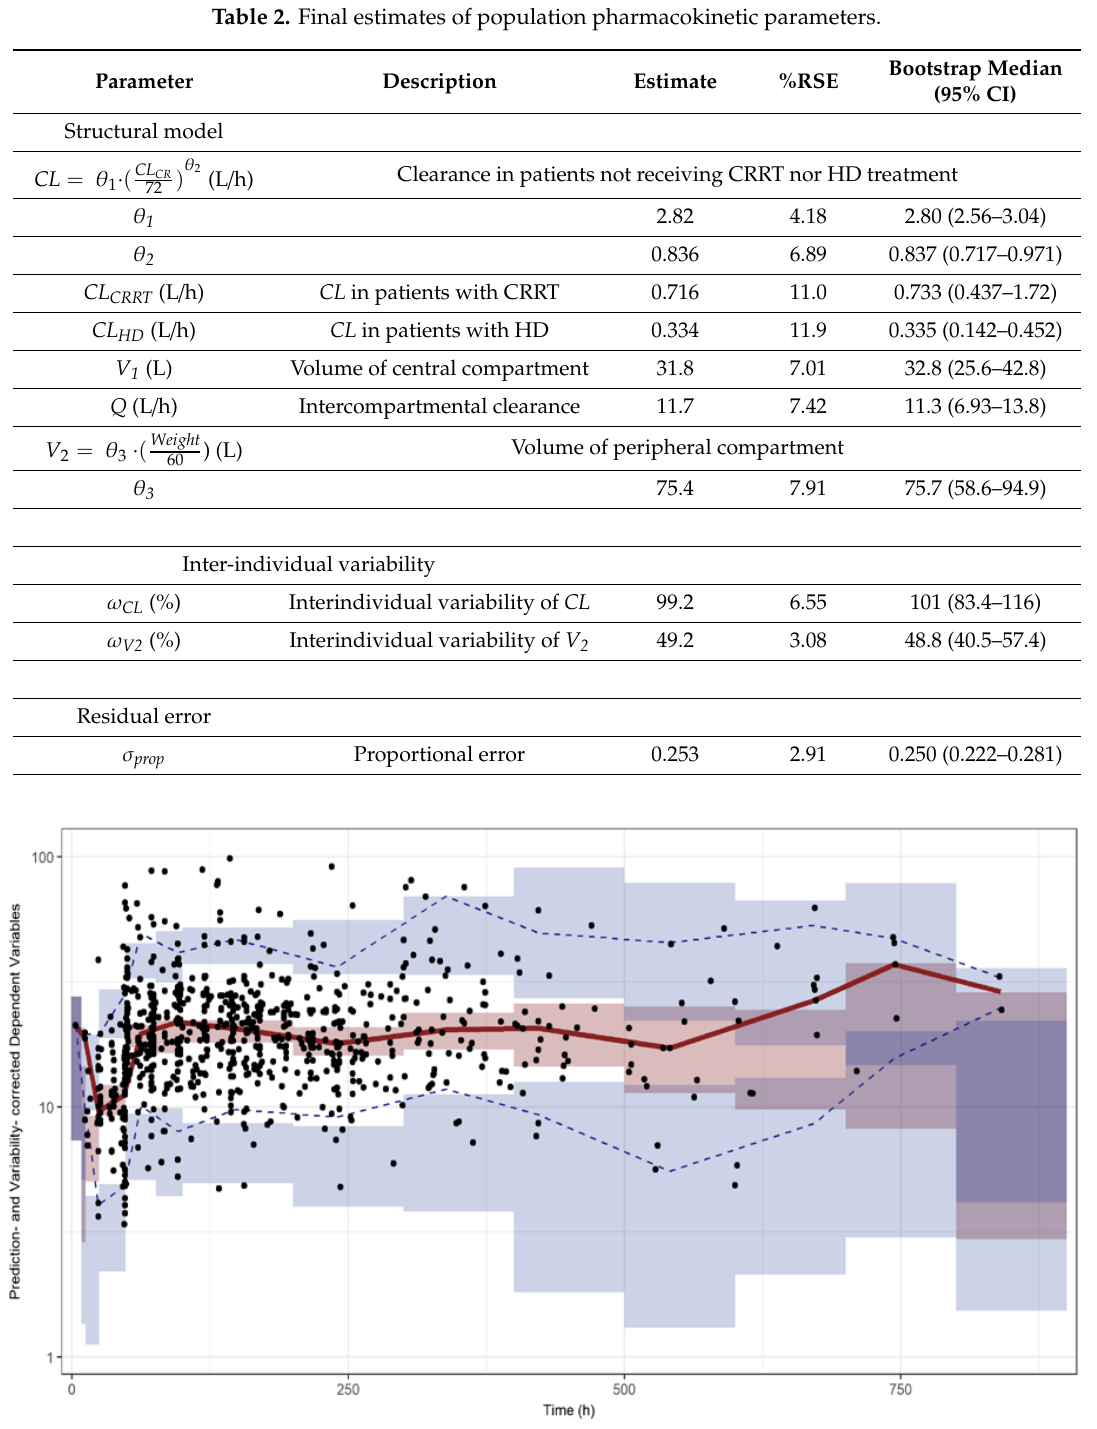
Figure 2. Prediction- and variability-corrected VPC plot. The dots are corrected observations, the solid red line represents the median of corrected observations, the dashed blue lines are 5% and 95% percentiles of corrected observations, the red field represents 95% confidence intervals for the prediction median, and blue fields represent the 95% confidence intervals for the margin of the 90% prediction interval.